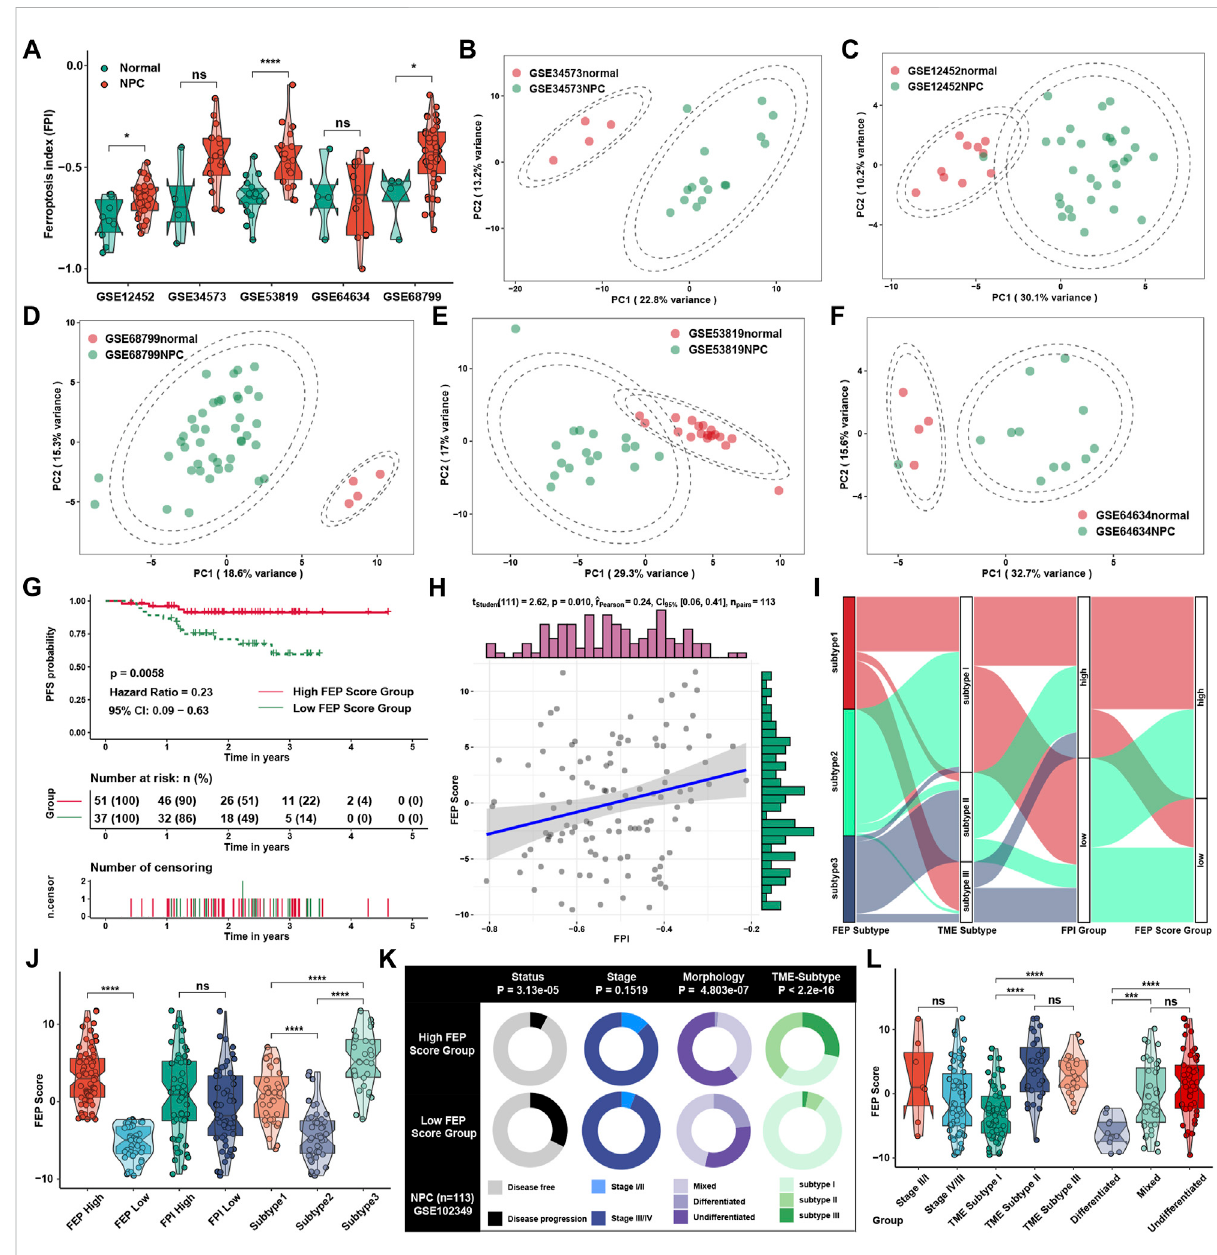
FIGURE 3 Generationof FEP score and functional annotation. (A) Differencesof FPI inNPC samples in comparison with normal tissue in fi ve independent NPC datasets in GEO database, including GSE12452, GSE34573, GSE53819, GSE64634 and GSE68799. (B – F) Principal component analysis for the ferroptosis regulators in fi ve independent datasets, showing a remarkable difference in mRNA expression between normal tissues and NPC. (G) Survival analysis for patients strati fi ed by FEP score in GSE102349. (H) Correlation analysis between FPI and FEP score. (I) Alluvial diagram visualizing the changes of ferroptosis subtypes, TME subtypes, FPI and FEP score. (J) FEP score among different ferroptosis subtypes, FPI and FEP score groups. (K) Clinical characterization in high and low FEP score groups. The chi-square test was used to calculate statistical differences. (L) FEP score among different clinical stages, TME subtypes and morphologies. The asterisks represented p values (* p < 0.05; *** p < 0.001; **** p < 0.0001) and ns represented no signi fi